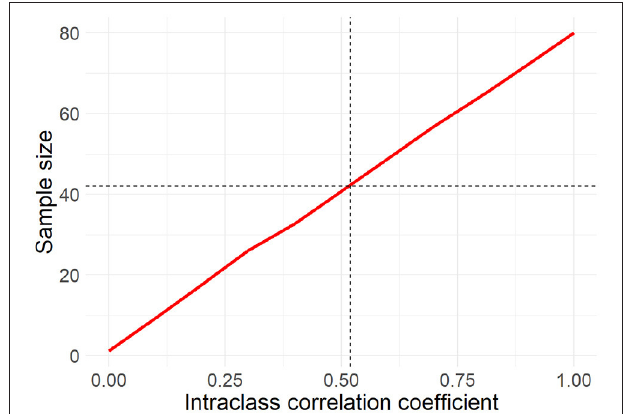
FIGURE 1 | Relationship between the intra class correlation coefficient and the sample size. With increasing correlation a larger sample size is needed to still detect the true effect with a probability of 80% at an alpha level of